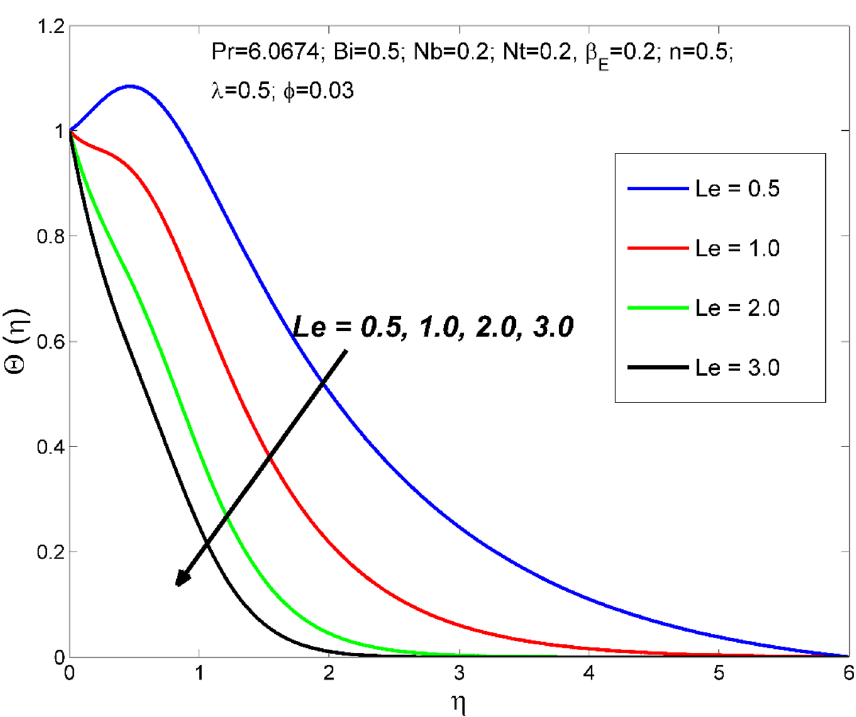
Figure 10. The nanoparticles volume fraction distribution �(η) behavior for the variation of the Lewis number Le